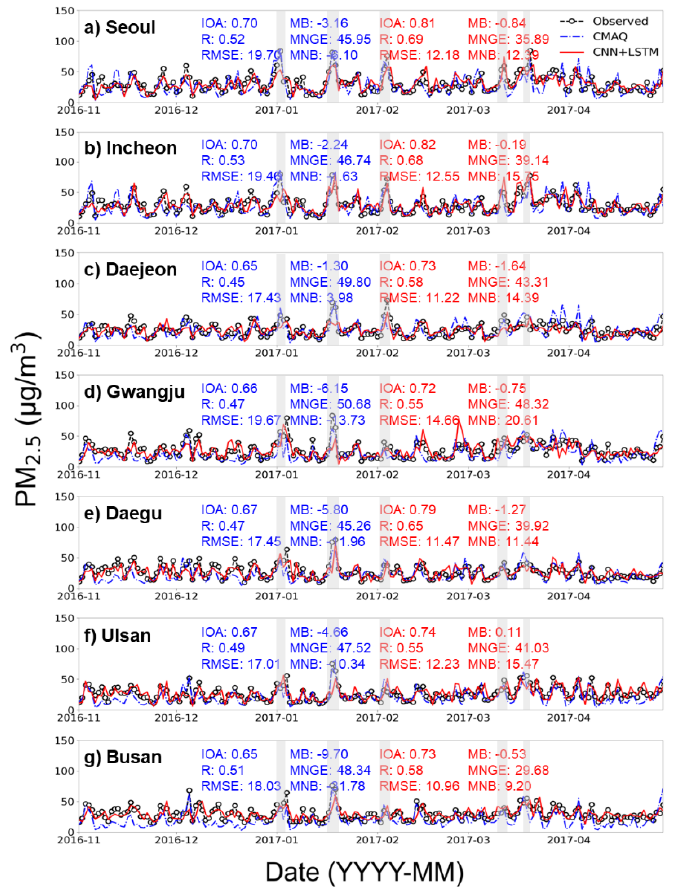
Figure 4. Comparisons between the observed, CMAQ-predicted, and the CNN+LSTM-predicted PM 2.5 at seven major cities in South Korea. Black-dashed line with an open circle represents the observed PM 2.5 . A blue-dashed line represents the CMAQ-predicted PM 2.5 . A red line represents the CNN+LSTM-predicted PM 2.5 . Grey shade represents the period with relatively high concentration among nationwide high PM 2.5 episodes.